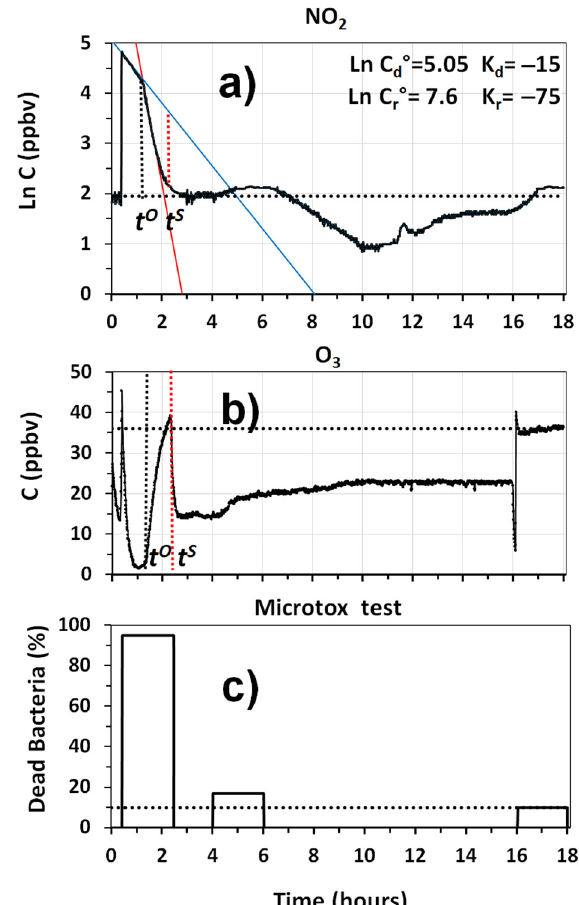
Figure 10. ( a ) Semi-logarithmic plots of NO 2 vs. time recorded in the room during an experiment performed with diesel emission using the SANINDOOR prototype as air cleaner. The meaning of solid lines in blue and red is the same as the previous figures. ( b ) O 3 variations measured during the same experiment. The time, t s , indicates the point at which the O 3 production by the cleaner was automatically cut by 50%. ( c ) Fraction of dead bacteria measured with the Microtox ® test, by collecting water samples during various phases of the removal experiment by using the GIOEL sys- tem.